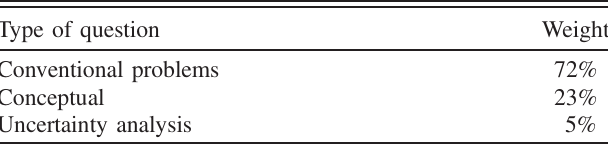
TABLE I. Questions on the final exam.